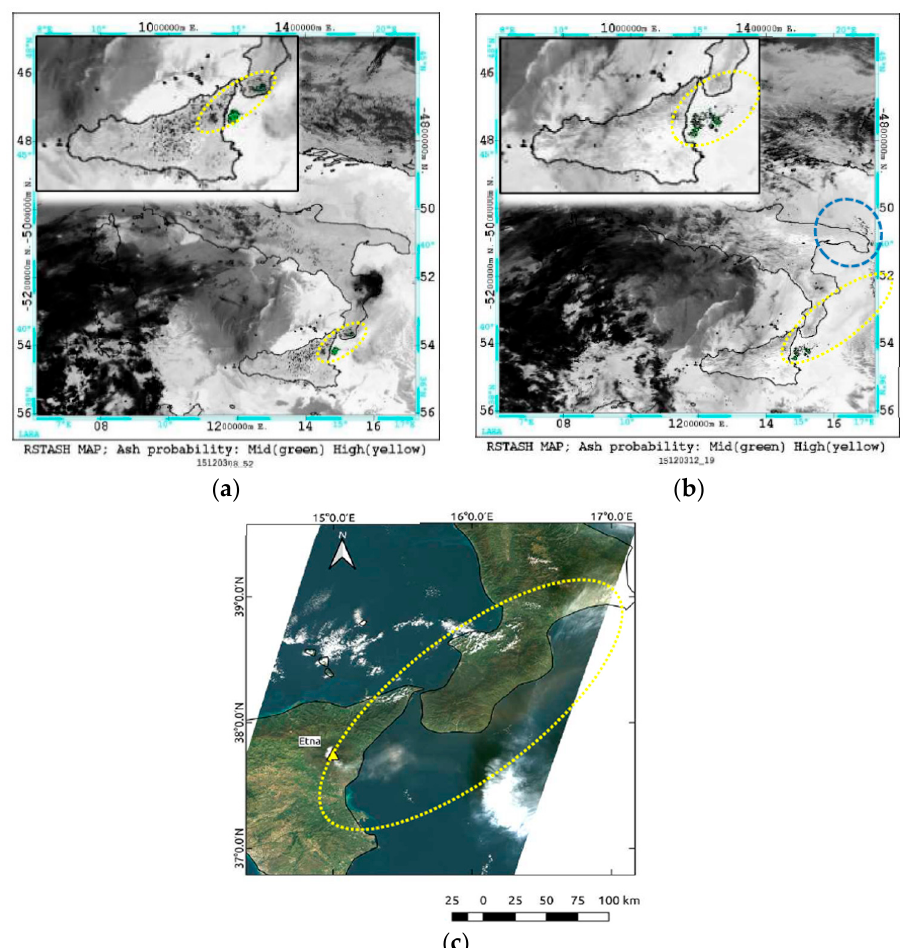
Figure 3. ( a ) Robust Satellite Techniques ‐ Ash (RST ASH ) map from Advanced Very High Resolution Radiometer (AVHRR) data of 3 December at 08:40 UTC (on the top ‐ left side of the panel, the zoom of detected ash pixels); ( b ) RST ASH map from AVHRR data of 3 December at 12:44 UTC; ( c ) Landsat ‐ 8 true color image (Red = Band 4: 0.630–0.680 μ m; Green = Band 3: 0.525–0.600 μ m , Blue = Band 2: 0.450–0.515 μ m) of 3 December at 09:35 UTC.